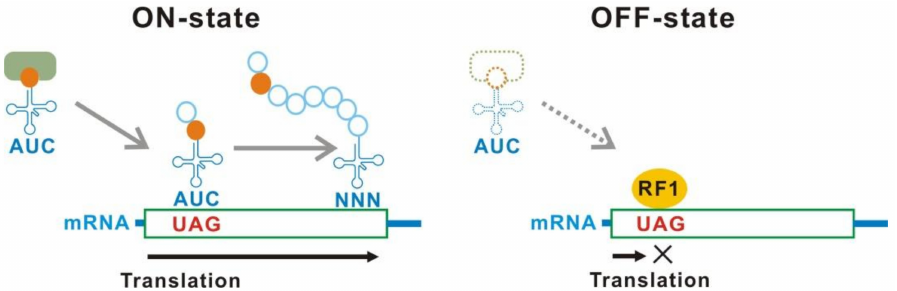
Figure 1. Translational switch using a UAG read-through in Escherichia coli . In the ON-state, an aminoacyl-tRNA CUA incorporates the amino acid at an inserted UAG in a target mRNA, resulting in a stop codon read-through and full-length translation of the target gene products. On the other hand, when the aminoacyl-tRNA CUA is not supplied in the OFF-state, the UAG is solely recognized as a stop codon and the synthesis of full-length products is interrupted by the peptide release factor 1. Circles and boxes indicate amino acids and protein coding regions in mRNAs, respectively. aaRS, aminoacyl-tRNA synthetase. tRNA CUA , UAG suppressor tRNA. RF1, peptide release factor